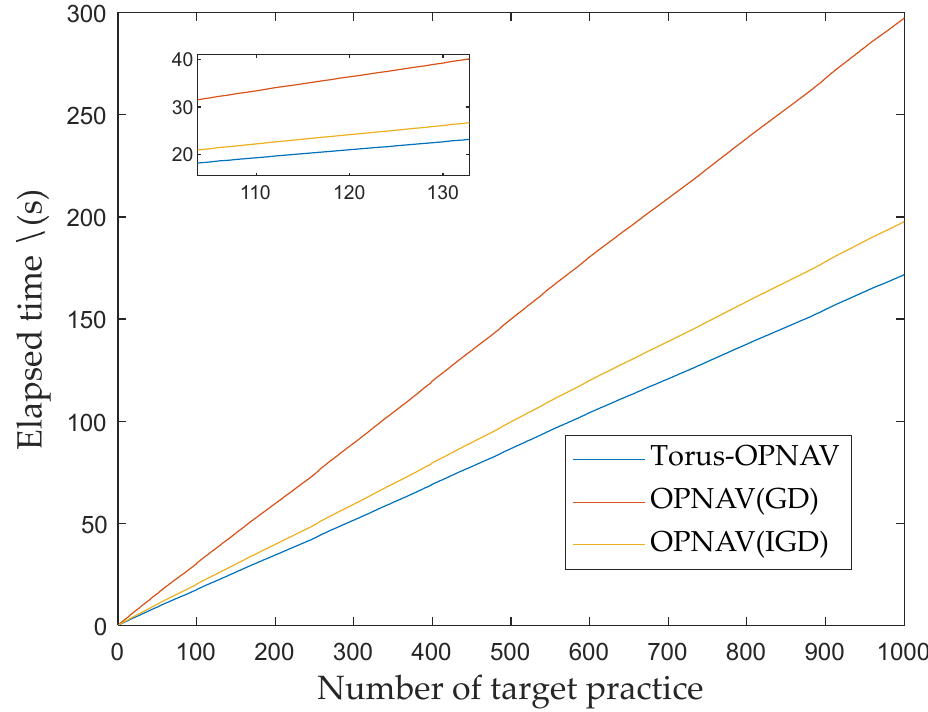
Figure 16. Hardware-in-the-loop simulation test environment.